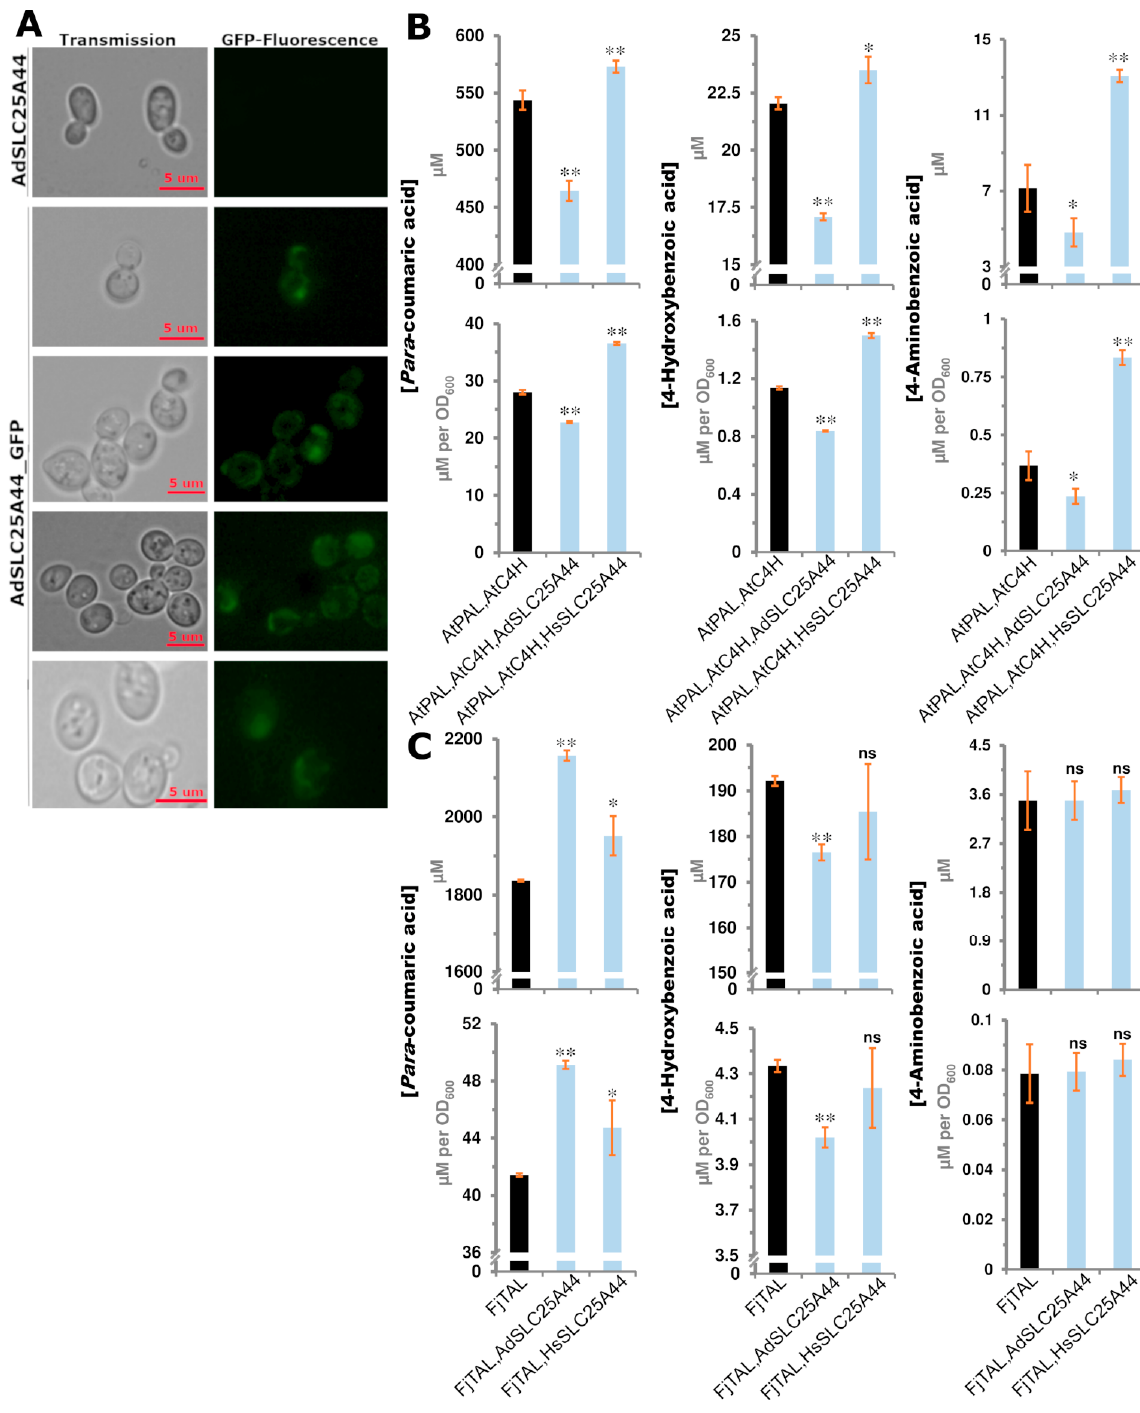
Figure 5. The transport activities of Ad SLC25A44 and Hs SLC25A44 in S. cerevisiae . ( A ) Subcellular localization of Ad SLC25A44_GFP in yeast. ( B , C ) Para -coumarate, 4-aminobenzoate, and 4-hydroxybenzoate concentrations in the fermen- tation broth after 72 h growth of the yeast strains producing para -coumaric acid from phenylalanine by the enzymes PAL and C4H ( B ) or from tyrosine by the enzyme TAL ( C ). Bars represent mean ± Std; n = 3 biological independent samples. The two-tailed Student’s t -test was used to compare the strains with and without the heterologous transporters. The significant events at 5% and 1% levels are labeled by one and two asterisks, respectively. C4H: Cinnamic acid hydroxylase, PAL: Phenylalanine ammonia-lyase, TAL: Tyrosine ammonia-lyase, and ns: not